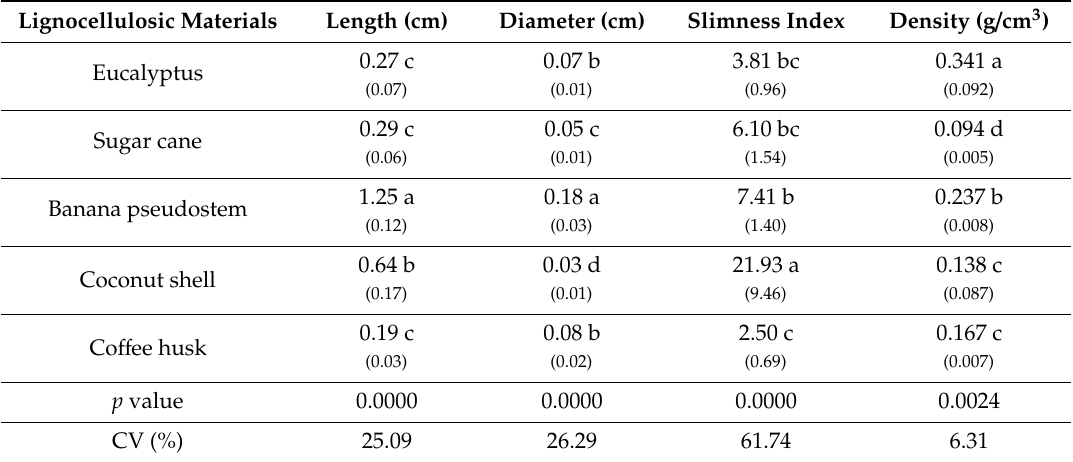
Table 2. Averagesandstandarddeviationsofthegeometryanddensitypropertiesofthelignocellulosiccomposites. Lignocellulosic